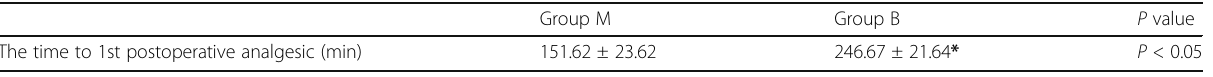
Table 5 The time to 1st postoperative analgesic (data are presented as mean ±